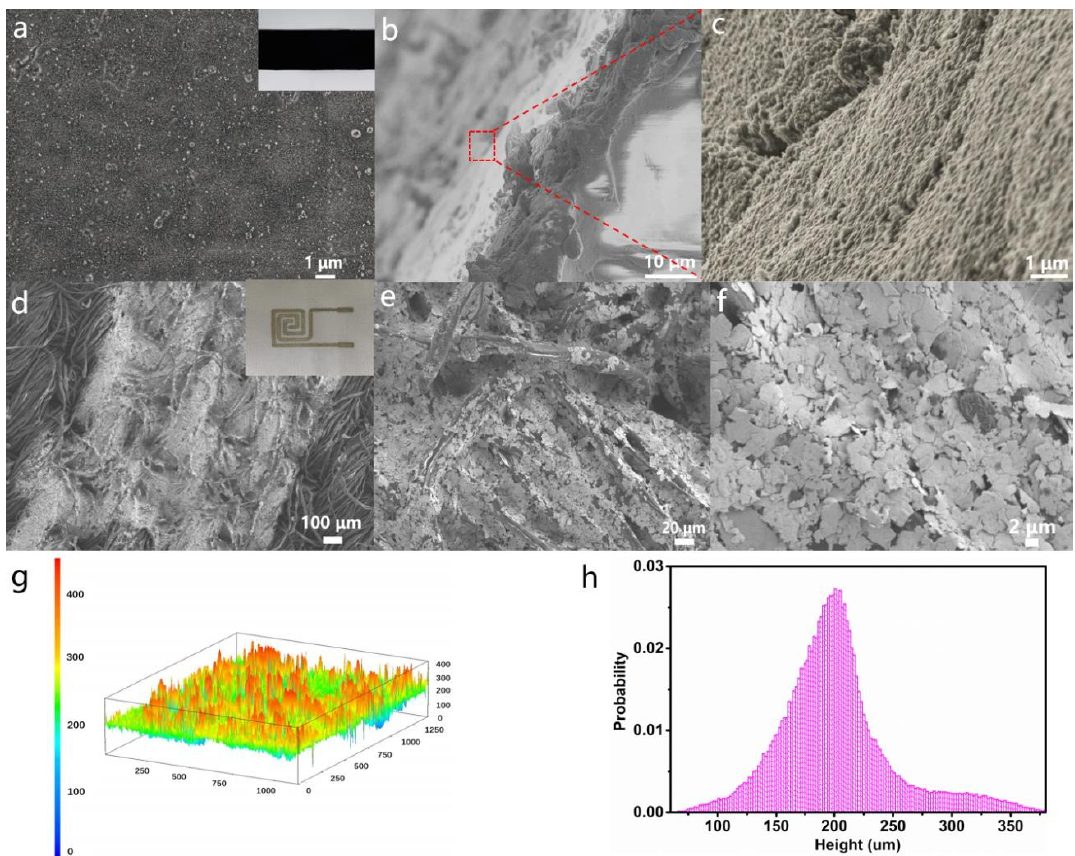
Figure 3. Morphological features of the NCB-coated PDMS surface. ( a ) A plane view of the SEM image of NCB-coated PDMS and its digital inset photograph. ( b , c ) Cross-sectional SEM images of the edge portion of NCB-coated PDMS under different magnifications. ( d ) SEM image of screen printed electrodes and the inset showing its digital photograph. ( e , f ) SEM image of the Ag electrode screen printed on textile under different magnifications. ( g ) 3D morphology of the Ag electrode-coated fabric. ( h ) The probability distribution of the surface heights.